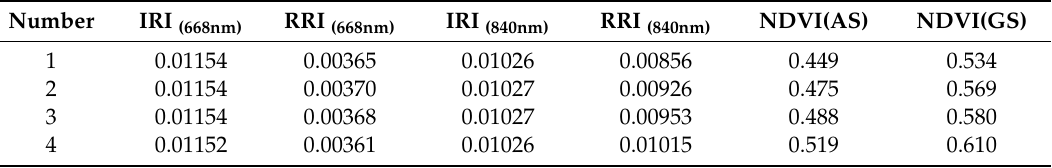
Table 8. Test data